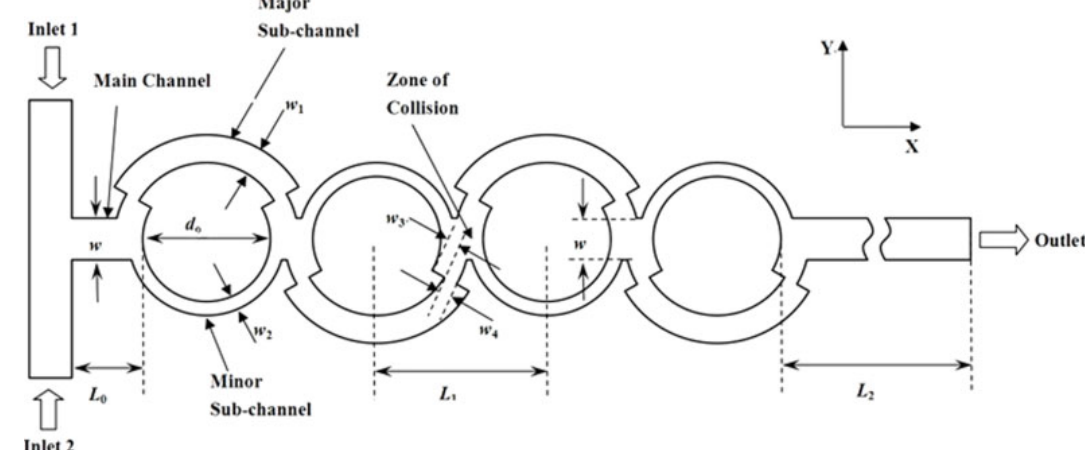
Figure 2. Curved micromixer with rectangular grooves: M-2 (no. of mixing units used: 8). Reproduced with permission from [41].